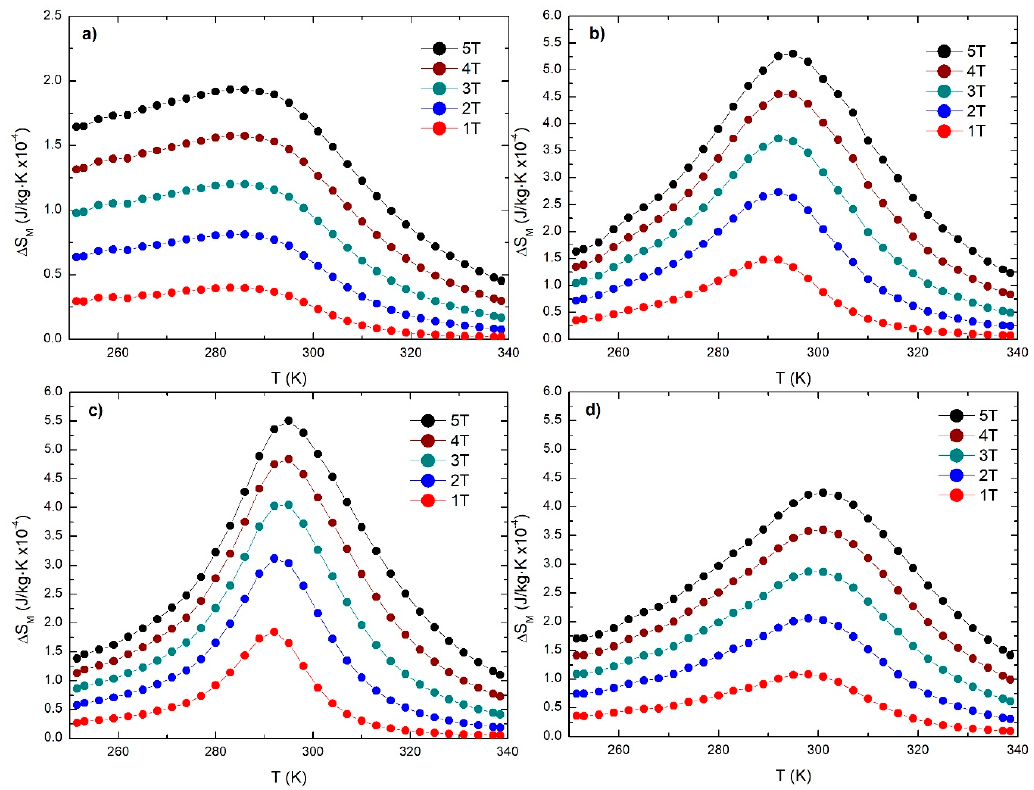
Figure 7. ∆ S M (T) curves with applied field of 10 kOe to 50 kOe for ( a ) microwaves-assisted sol-gel, ( b ) Pechini sol-gel, ( c ) solid-state reaction with planetary mill and ( d ) solid-state reaction with attrition mill.